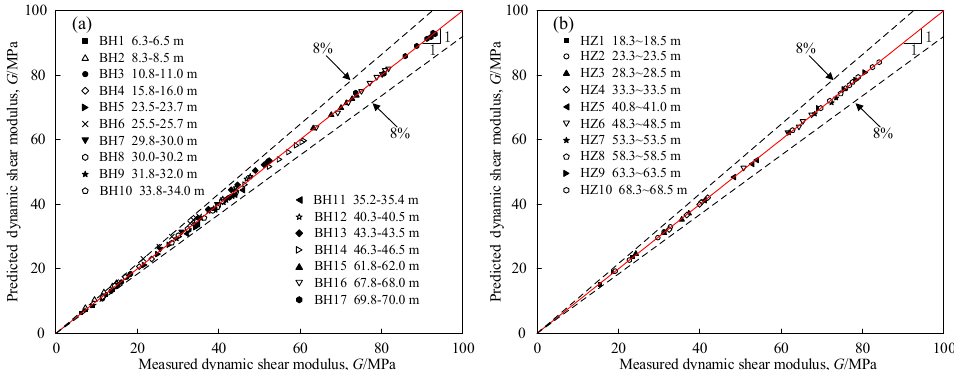
Figure 8. Comparison of predicted and measured values of the dynamic shear modulus G of marine clays from ( a ) Bohai Bay; ( b ) Hangzhou Bay.